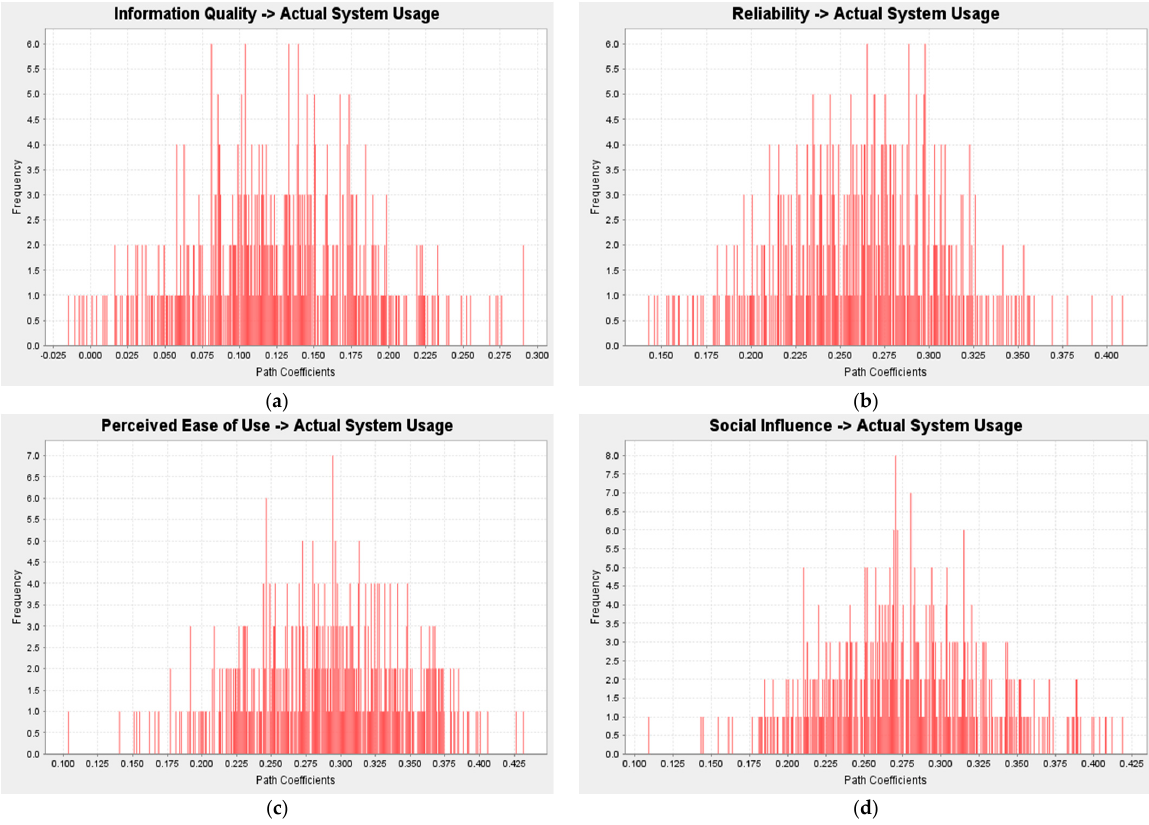
Figure 4. Path Coefficient Diagram; ( a ) Information Quality to Actual System Usage; ( b ) Reliability to Actual System Usage; ( c ) Perceived Ease of Use to Actual System Usage; and ( d ) Social influence to Actual System Usage. Table 6. T-Test with a Significance Level.